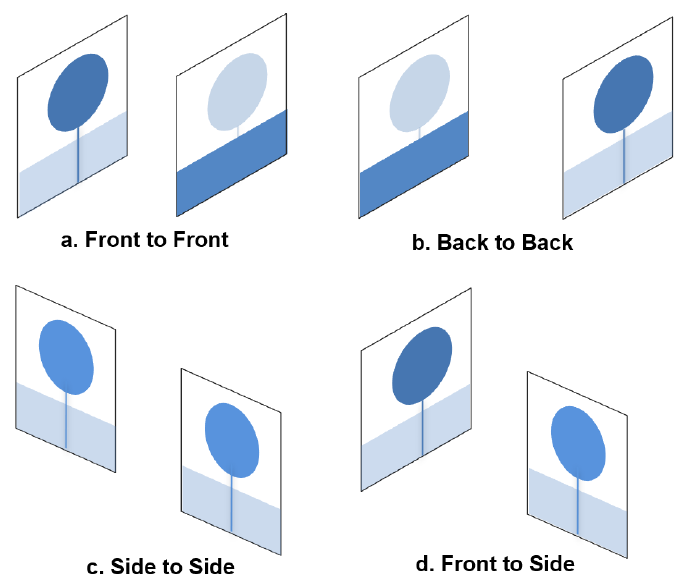
Figure 9. Setup of UWB antennas positions in wireless link.